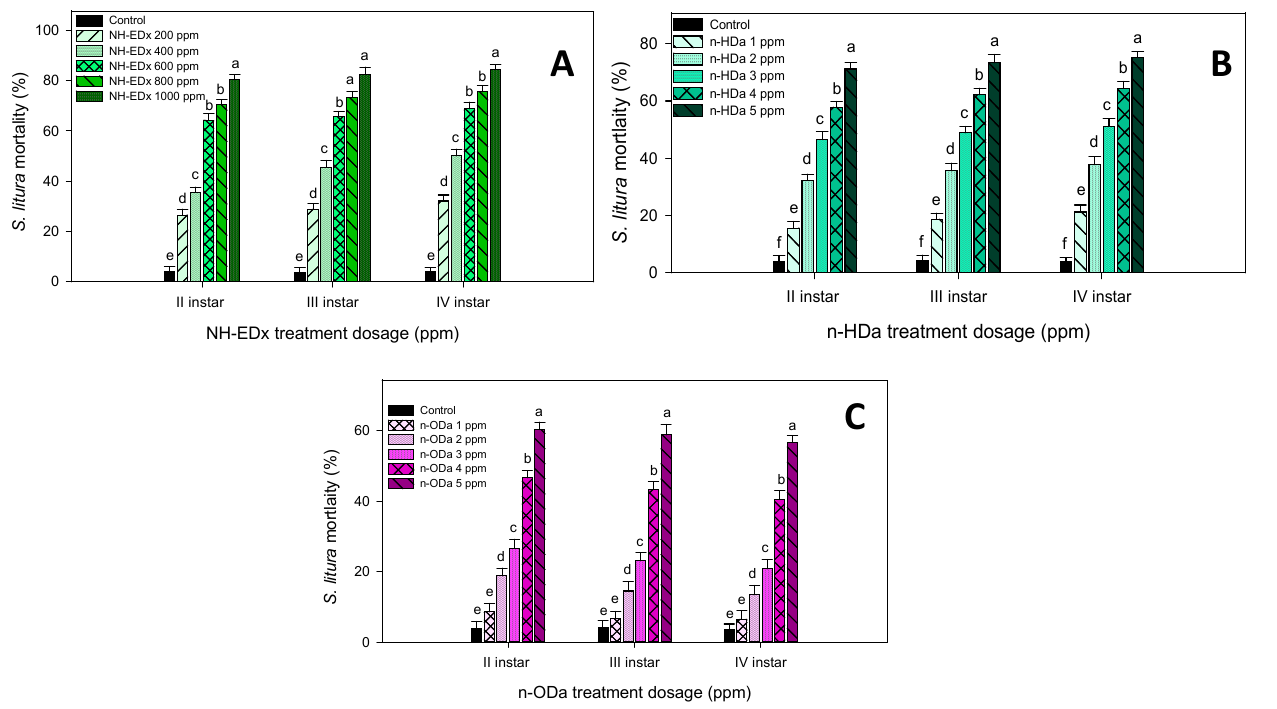
Figure 2. Percentage mortality of second, third, and fourth instar larvae of A. aegypti after treatment with NH-EDx ( A ), n - HDa ( B ), and n -ODa ( C ). Means (±SEM) followed by the same letters above bars indicate no significant difference ( P ≤ 0.05) according to a Tukey’s test.